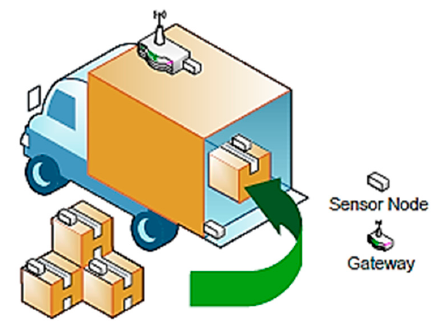
Figure 15. Depiction of the basic configuration of a WSN based system for transport logistics applications [36].